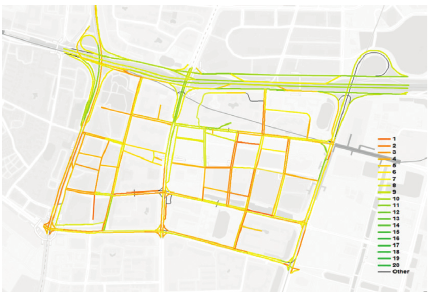
Figure 19: The distribution of predicted traffic speed on the road